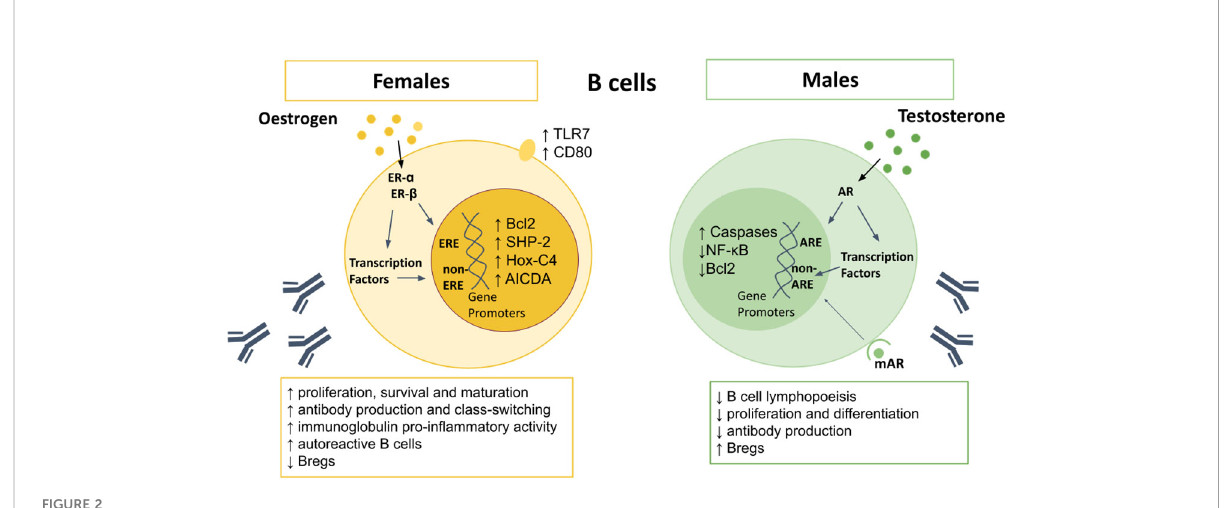
FIGURE 2 Sex differences in B cells. AR signaling appears to upregulate caspases, and downregulate NF- k B and Bcl2, resulting in increased B cell apoptosis. Males also demonstrate reduced B cell lymphopoiesis in the bone marrow, reduced proliferation and differentiation of B cells, and lower antibody production, but higher Bregs. Oestrogen upregulates Bcl-2, SHP-2, Hox-C4, and AICDA, as well as surface expression of TLR7 and CD80. Female B cells demonstrate higher proliferation, survival and maturation, higher pro-in fl ammatory antibody production, leading to higher levels of autoreactive B cells. AICDA, Activation-induced cytidine deaminase; AR, androgen receptor; Bcl-2, B cell lymphoma 2; Bregs, regulatory B cells; Hox-C4, homeobox protein C4; IFN, interferon; IL, interleukin; NF- k B, nuclear factor kappa-light-chain-enhancer of activated B cells; SHP-2, Src homology region 2 domain- containing protein tyrosine phosphatase; TLR, toll-like